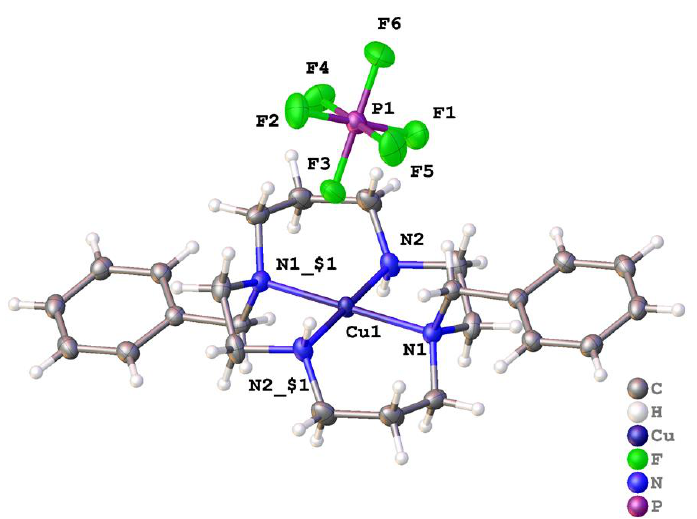
Figure 10. Coordination about the metal ion in [Cu( 2 )](PF 6 ) 2 . Atoms are drawn as 50% probability ellipsoids. Symmetry operation for generating equivalent atoms: $1 = 1 − x , 1 − y , 1 − z .